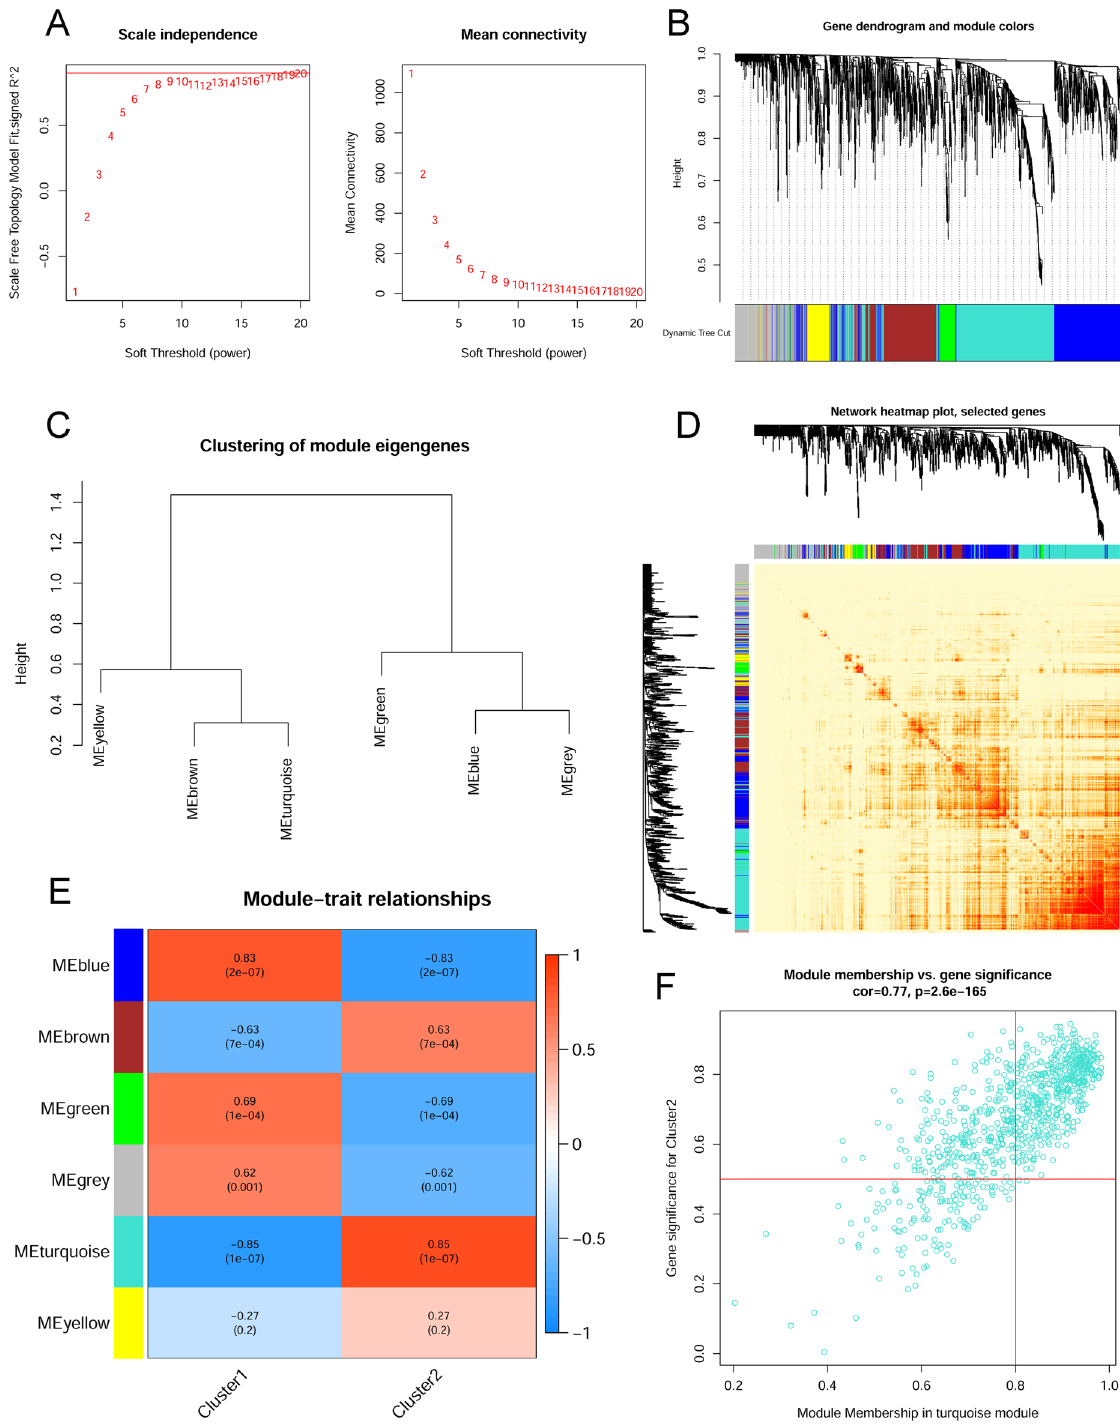
Figure 6. Co-expression network of DEGs between two cuproptosis clusters. ( A ) The option of soft threshold (power). ( B ) Clustering dendrogram of genes in co-expression modules. Distinct co-expression modules were shown in different colors. ( C ) Clustering of module eigengenes. ( D ) The correlations heatmap among 6 modules. ( E ) Correlation analysis between module eigengenes and clinical status. A module is represented by a row, and a clinical status is represented by a column. ( F ) Scatter plot between module membership in turquoise module and the gene significance for